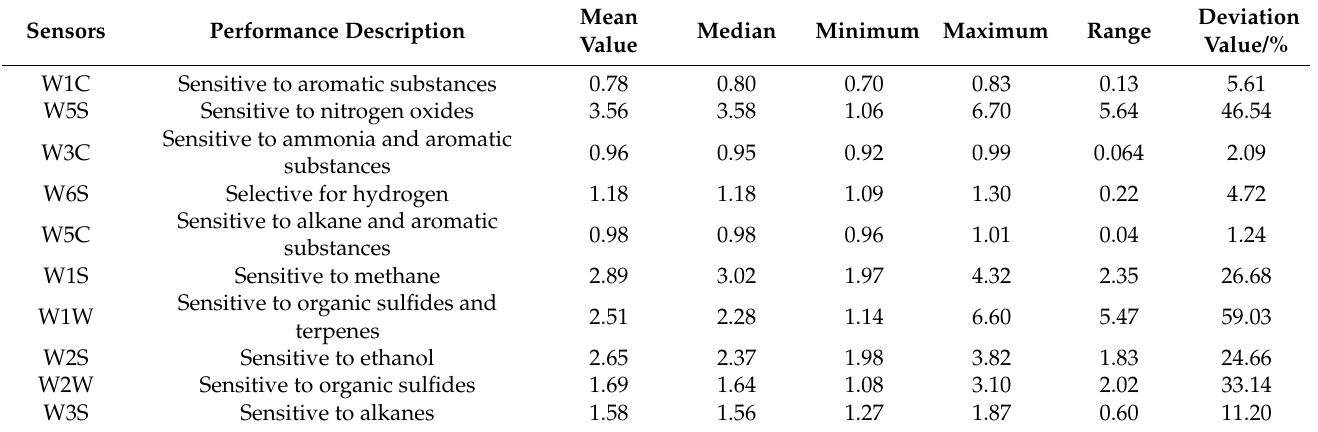
(Table 1) and multivariate statistical methods (PCA, CA, PLS-DA, etc.) could also be used to compare the similarity and difference of volatile flavour in different groups of samples. Table 1. The analysis of relative intensity of each flavour index in low-salt hotpot sauce samples stored in 4 ◦ C ( n = 16, 4 different concentration × 4